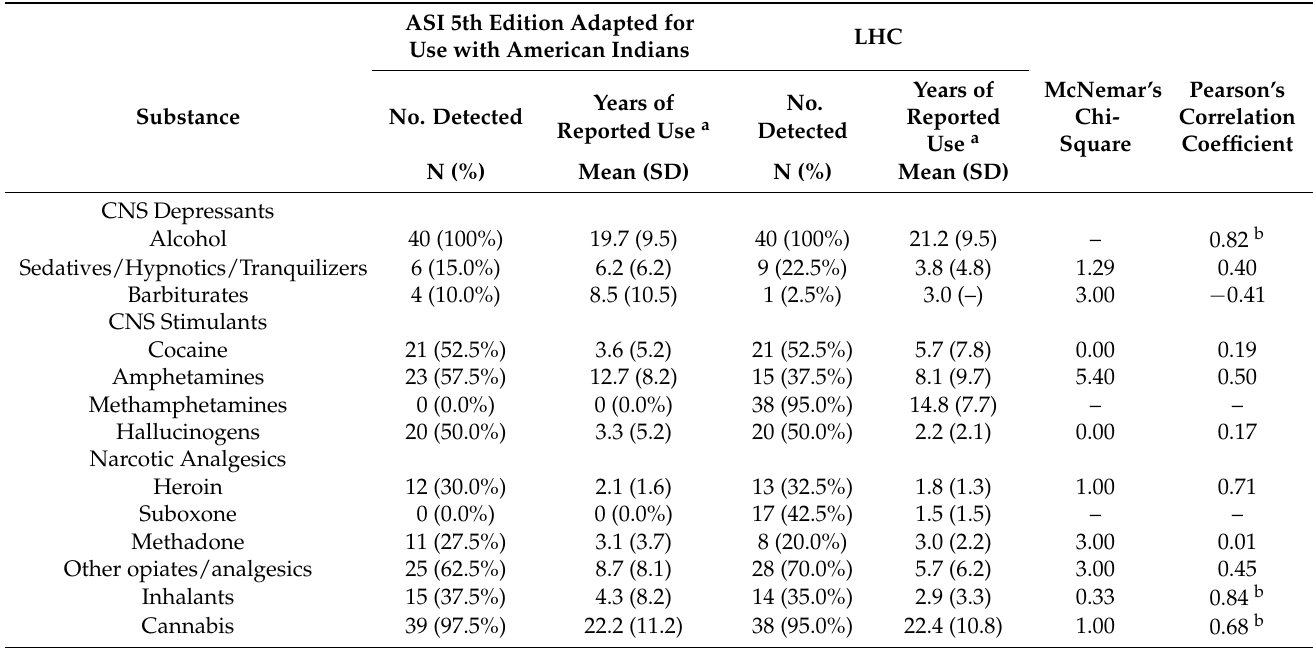
Table 3. Comparison of lifetime recall of substances used via the Life History Calendar and the Addiction Severity Index 5th Edition adapted for use with American Indians among Assiniboine and Sioux people who use injection drugs, n =